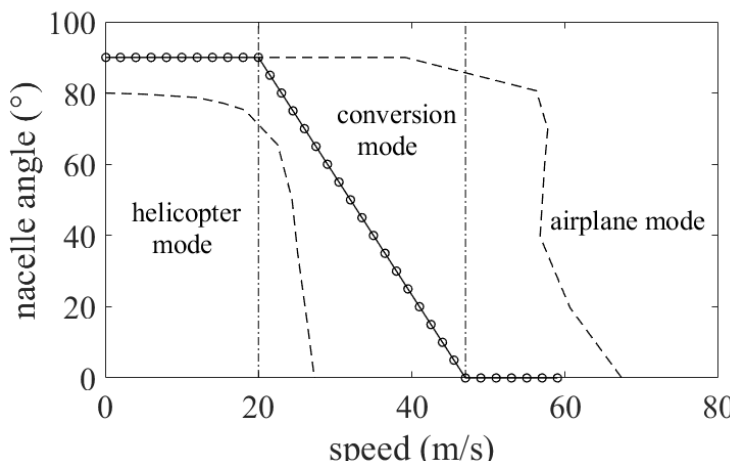
Figure 9. Conversion corridor of quad tiltrotor and selected trimming points. At these trimming points, the vehicle is in equilibrium. In this case, the body resultant forces and moments are zero. Therefore, the body translational accelerations, angular rates, and angular accelerations of the vehicle are zero. Additionally, the flapping motion of the rotor maintains a steady state, and Equation (3) can be written as follows.